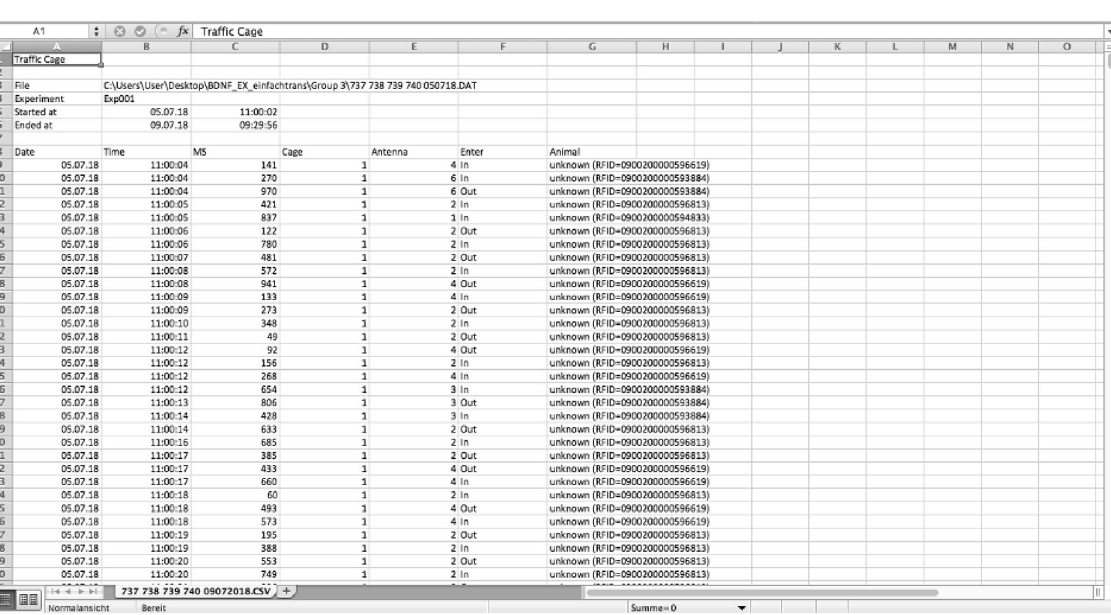
Figure 3. SCA data exported to a spreadsheet program. It is noted at which point of time (“Date”; “Time”) which animal (“ANIMAL”—“RFID number”) entered or left which antenna (“Cage”; “Antenna”; “Enter”—“IN”; “ENTER”—“OUT”) and how long it stayed there